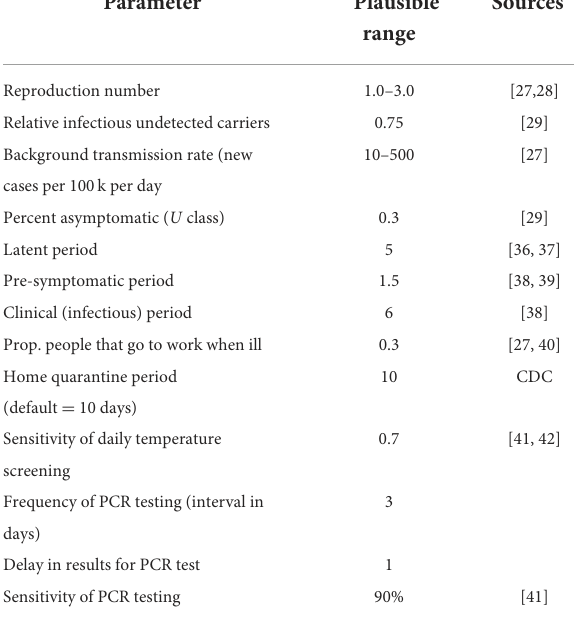
TABLE 1 Model parameter